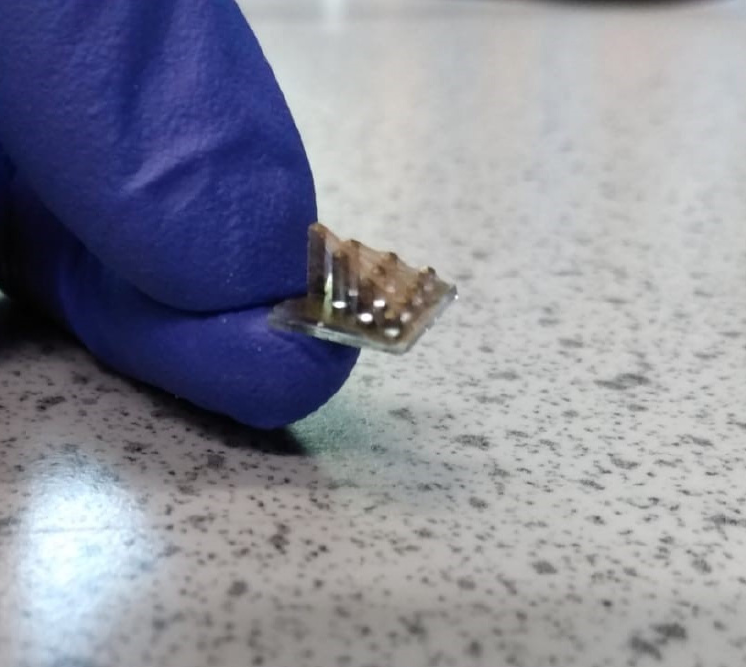
Figure 9. A prototype of the device including electrospun PVDF nanofibers mimicking the tip-link behavior on top and PDMS pillars substrate.